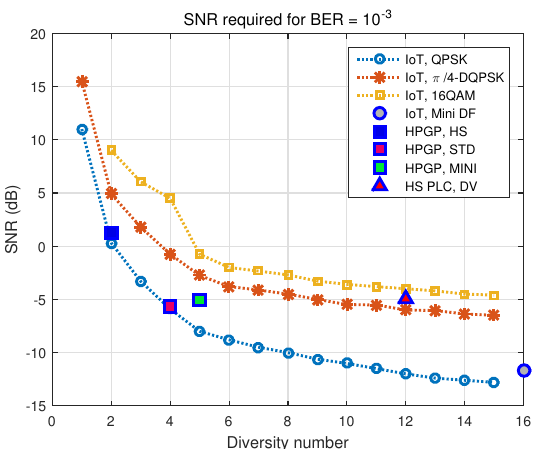
Figure 21. Comparisons of SNR required for BER of 10 − 3